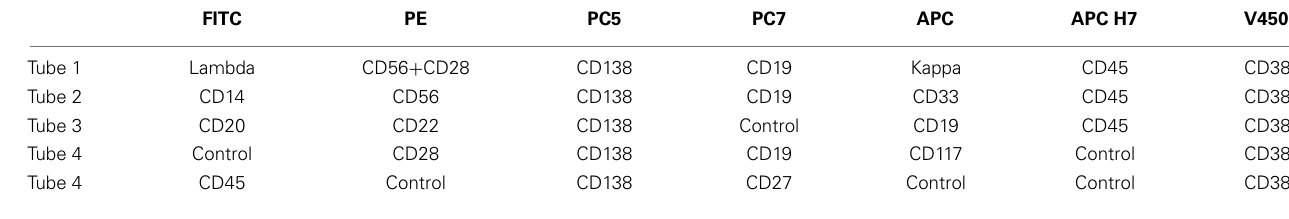
Table 1 | Panels of antibodies used for immunophenotyping of MM PC